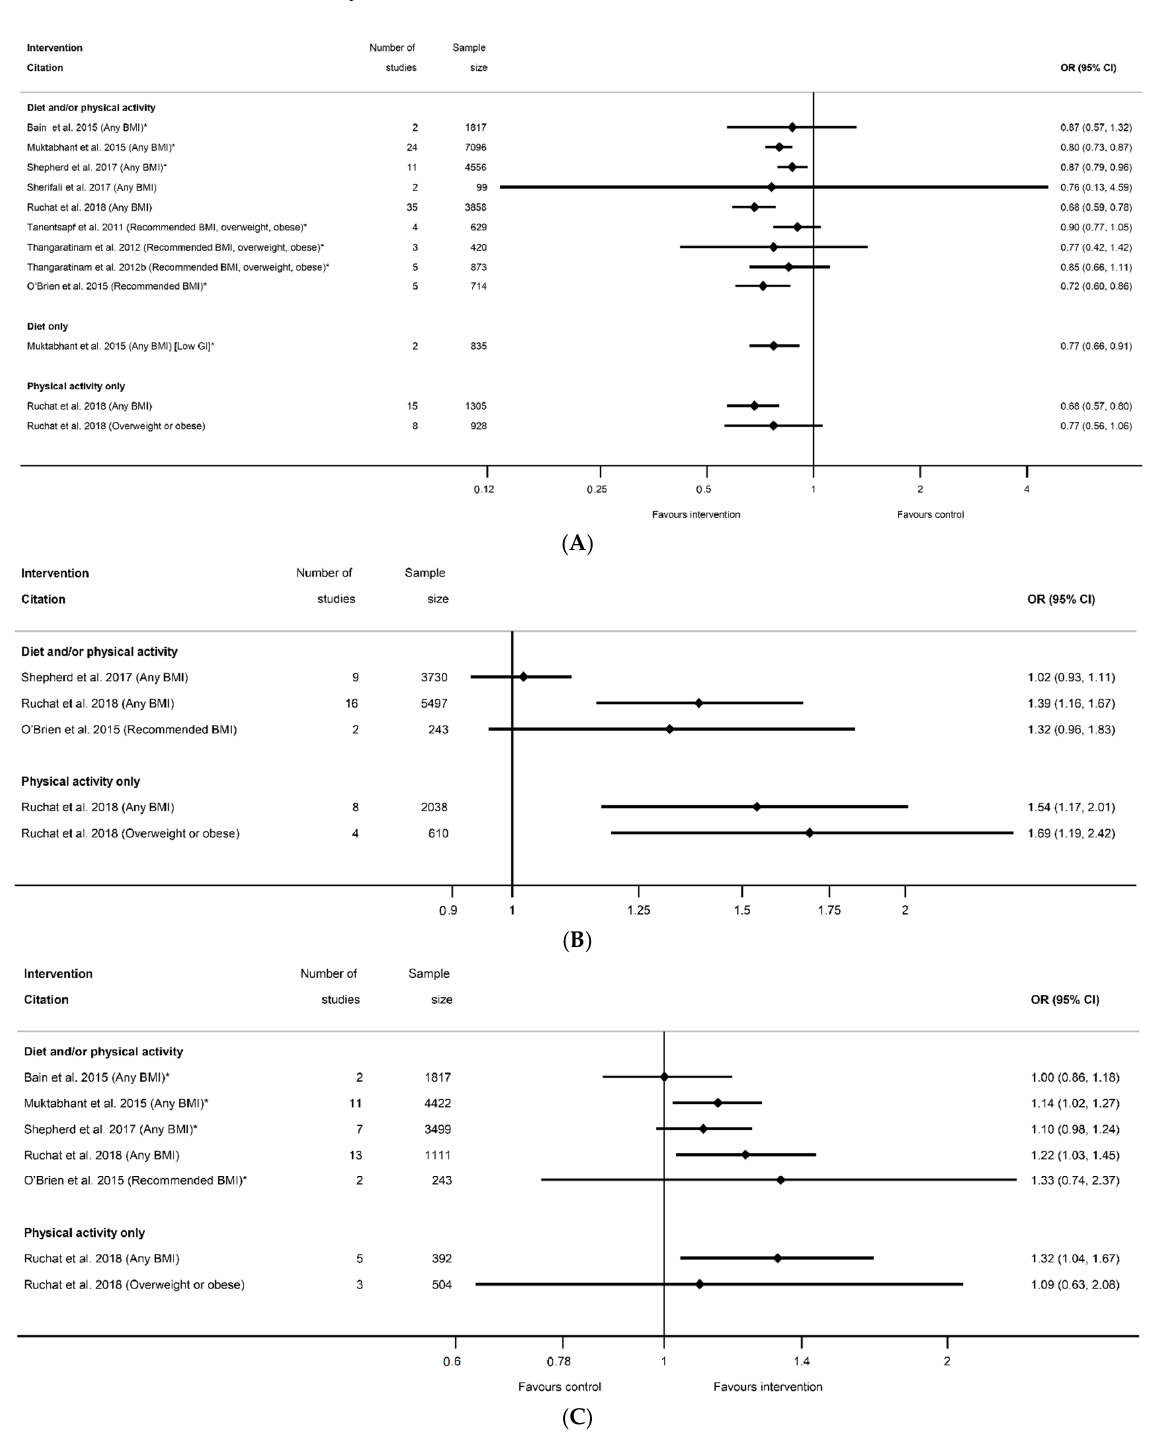
Figure 4. Forest plot of meta-analysis results for excess, adequate and inadequate gestational weight gain (GWG); ( A ) excessive GWG, ( B ) adequate GWG, ( C ) inadequate GWG. * indicates the estimate is relative risk. Sixteen meta-analyses for postnatal weight retention were reported by seven system- atic reviews for diet and/or physical activity interventions ([28,29,40,50,60,77,81], and one